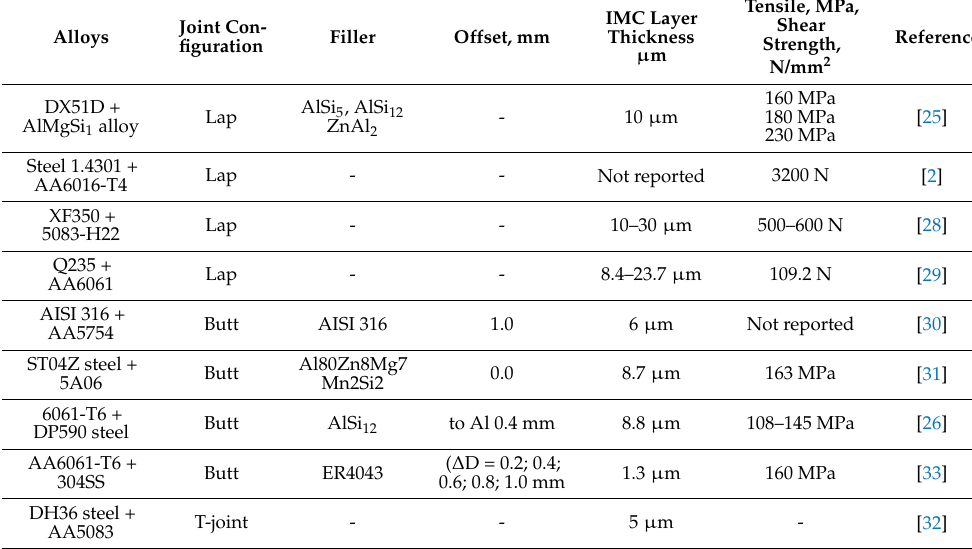
Table 4. Analysis of laser welding techniques for steel and aluminum, comparison of joint strength and IMC. Author’s own Table.